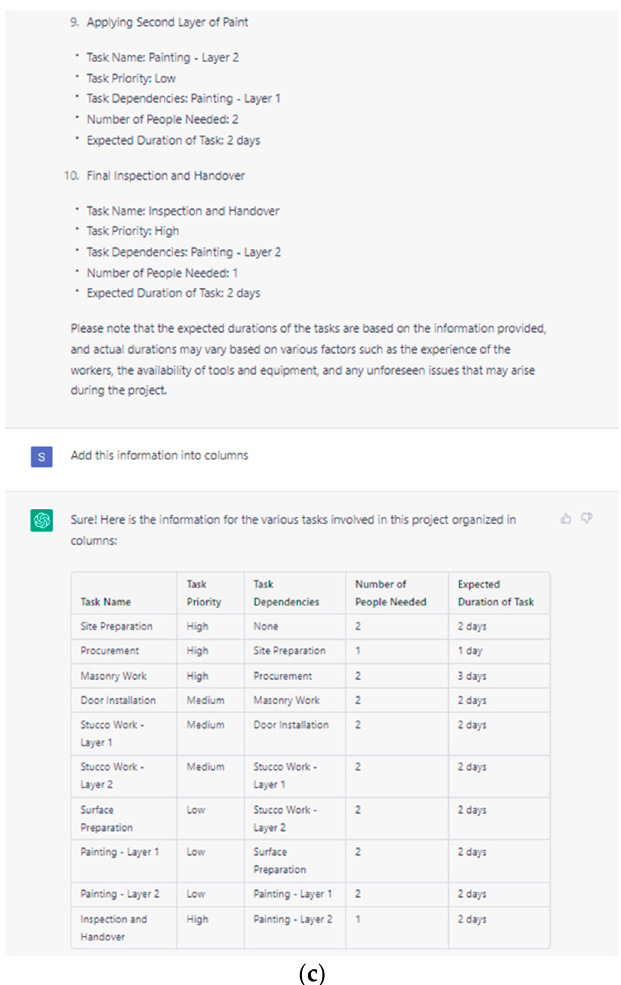
Figure A1. Extracts of the ChatGPT interface with the prompts regarding ( a ) the initial instruction and the scope of work, ( b ) the request to detail tasks in a given format, and ( c ) displaying the proposed schedule in a table.